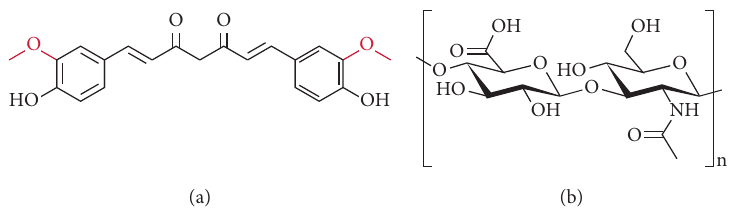
Figure 1: Structure of (a) curcumin and (b) hyaluronic acid.